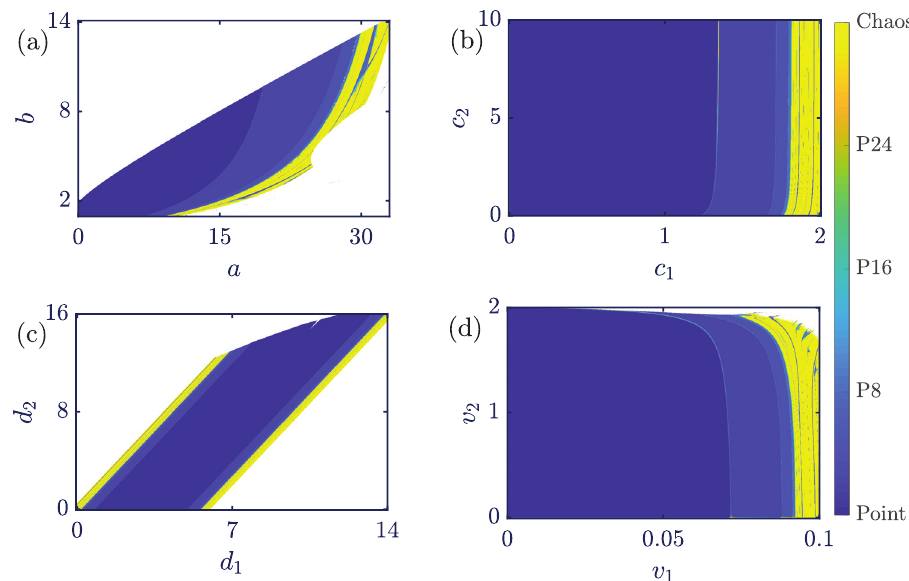
Fig 11. Two-dimensional bifurcation diagrams of Eq (13) with initial conditions q 1 (0) = q 2 (0) = 1 in (a) a − b , (b) c 1 − c 2 , (c) d 1 − d 2 , and (d) v 1 − v 2 parameter spaces. The white, yellow, and dark blue regions represent unbounded, chaotic, and fixed point solutions. Each panel is obtained by simulating a grid of 1000 × 1000 parameters that are changing, and the remaining parameters are kept fixed at a = 6, b = 0.5, c 1 = 2, c 2 = 1, d 1 = 0.5, d 2 = 1, v 1 = 0.1, and v 2 = 1. By increasing the number of periods in a periodic attractor, the blue component of its representative color decreases, and the yellow component dominates. Both convergences to the Nash equilibrium and chaotic behaviors can be perceived in all of the panels, which shows the superior capability of the proposed model.